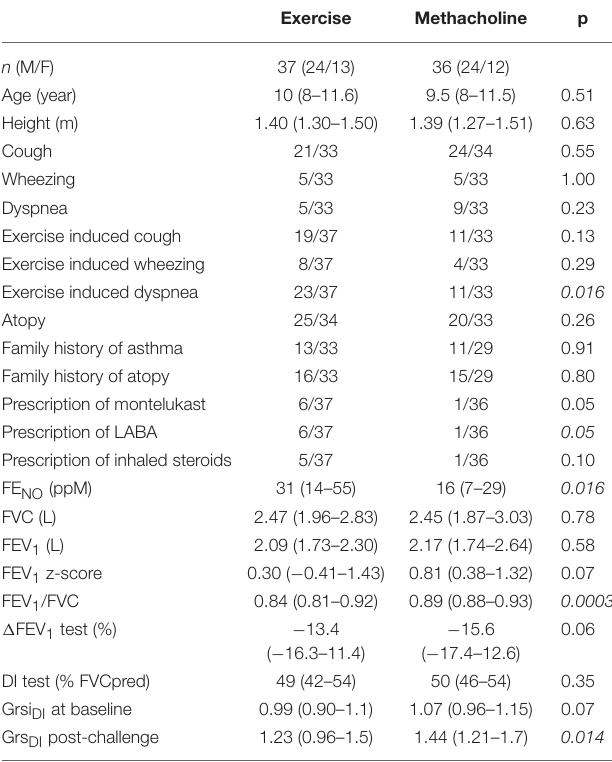
TABLE 1 | Characteristics of the